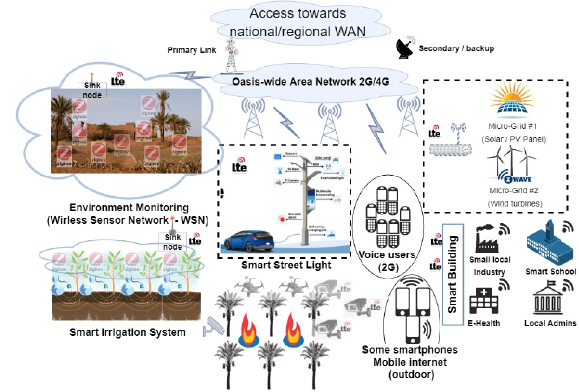
Figure 6 . Hierarchical architecture for communications networking layer in smart